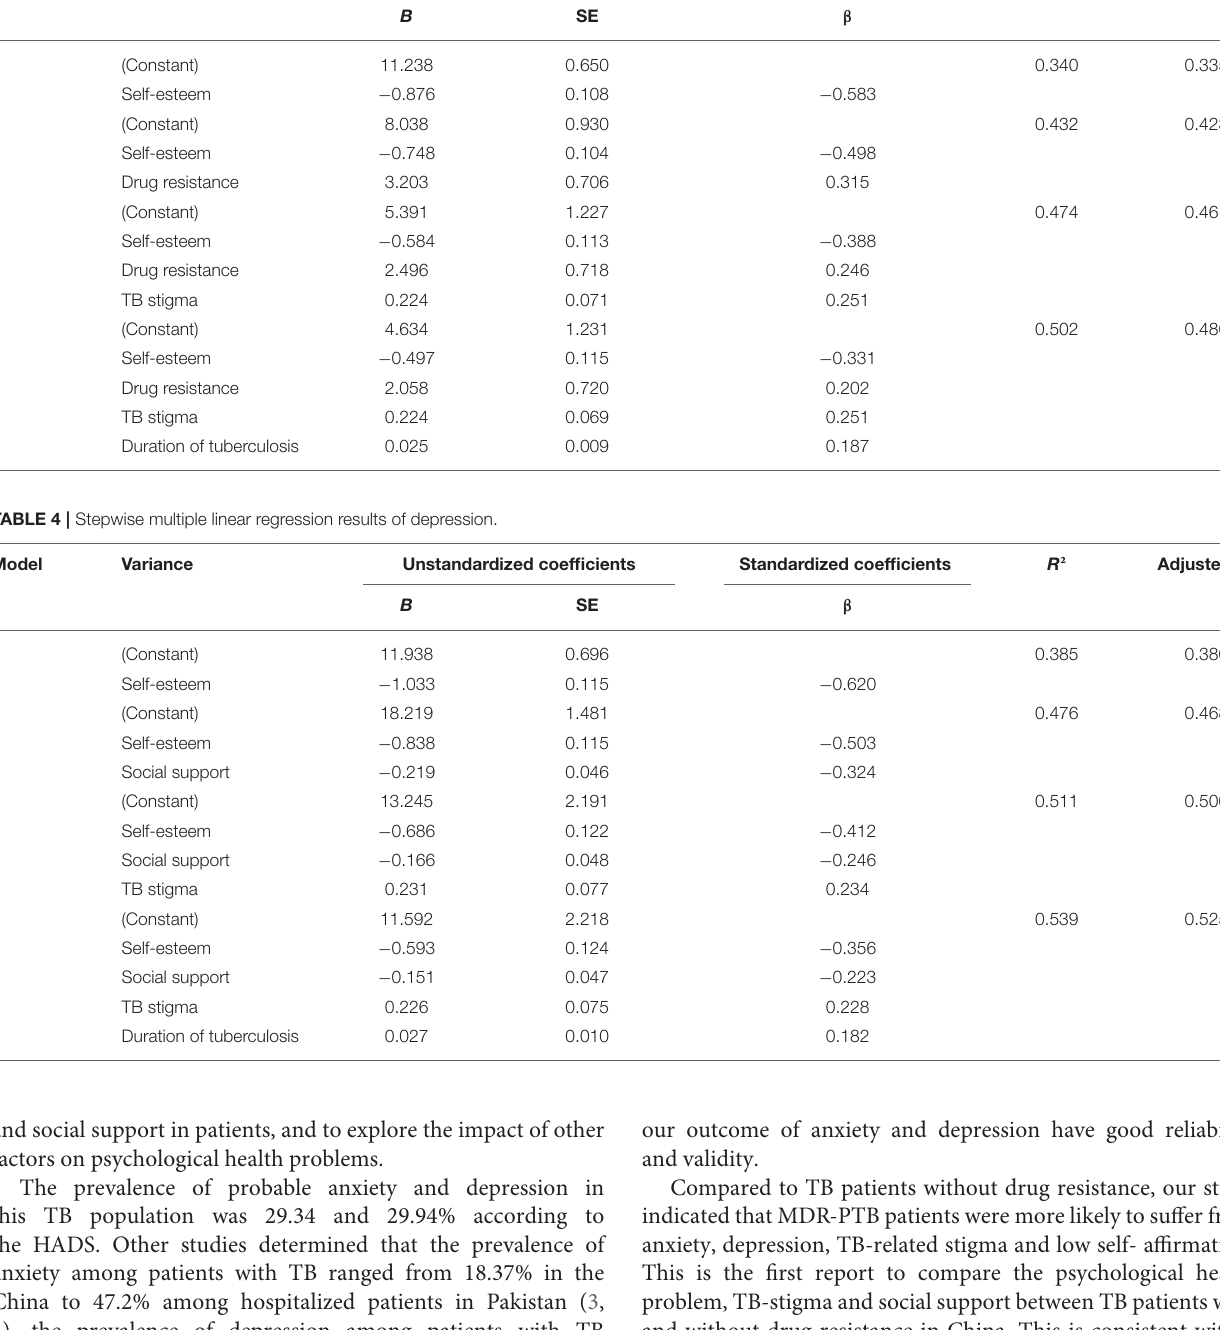
TABLE 3 | Stepwise multiple linear regression analysis results of anxiety. Model